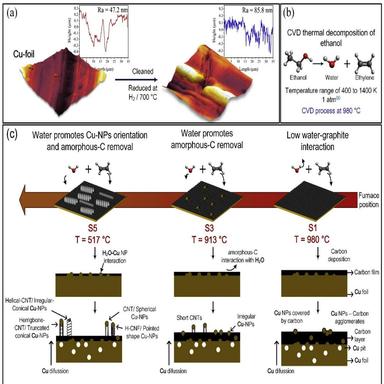
Growing mechanism explained in three stages: (a) Modification of roughness of copper foil due to a cleaning and reduction process. (b) Ethanol decomposition mechanism in a CVD process. (c) Growing stages inside the quartz furnace where water interaction with Cu substrate and graphite plays a role over the growing of different carbon nanostructures. (A colour version of this figure can be viewed online.)